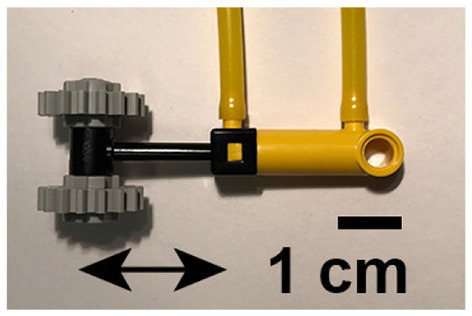
Photograph of one of the eight pneumatic tactile stimulators used for somatosensory topographic mapping experiments. Arrows depict direction of travel of toothed wheels. Black line shows 1 cm scale.